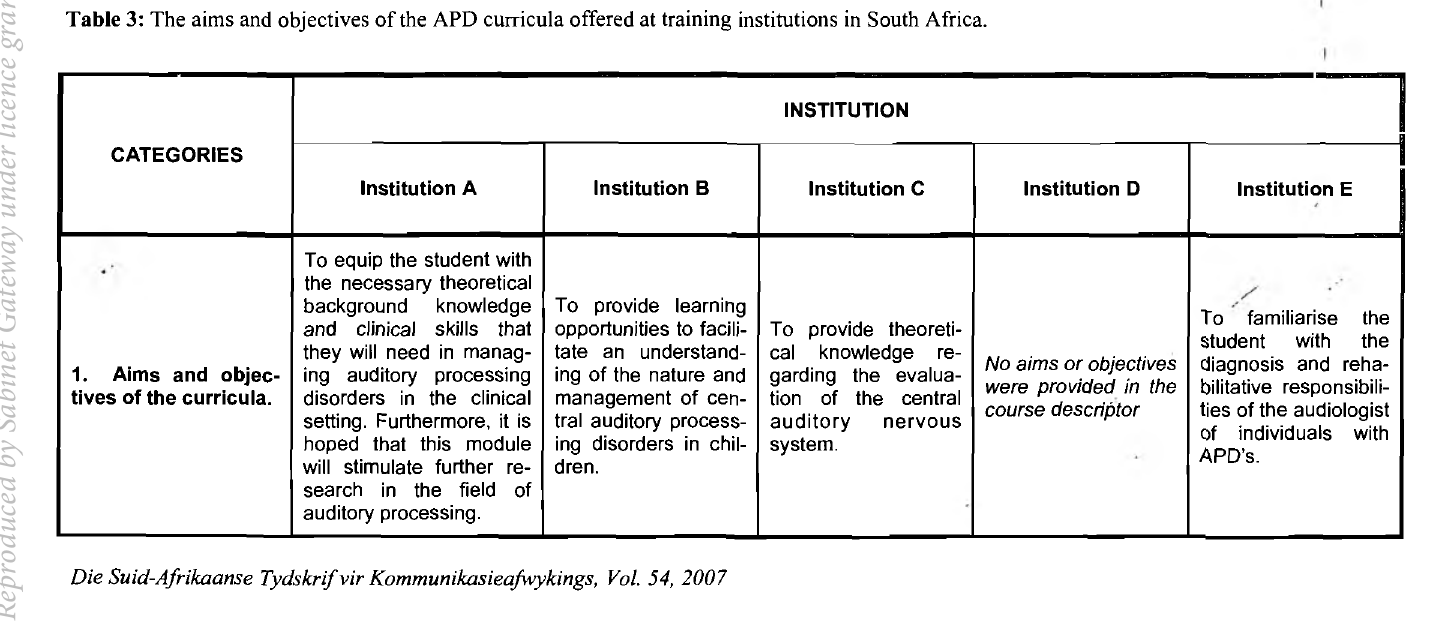
Table 3: The aims and objectives of the APD curricula offered at